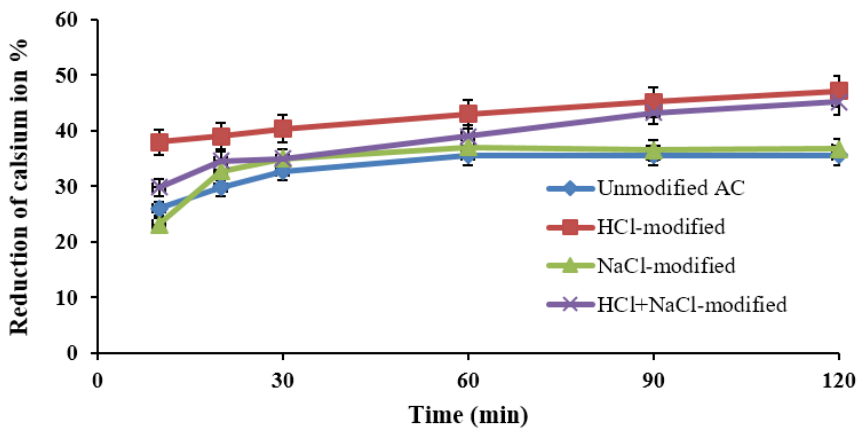
Figure 9. The reduction in calcium ions in drinking water versus time using activated carbon and modified forms.